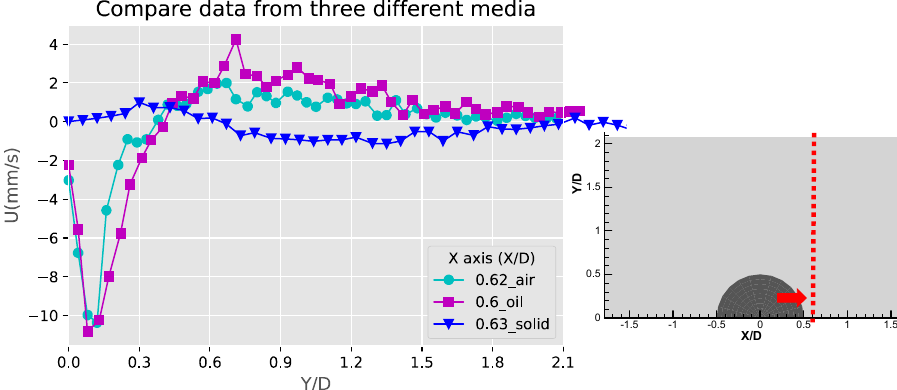
Figure 14. Comparison of the X-component velocity (U) profiles at the right side of the obstructions (X/D = 0.6).